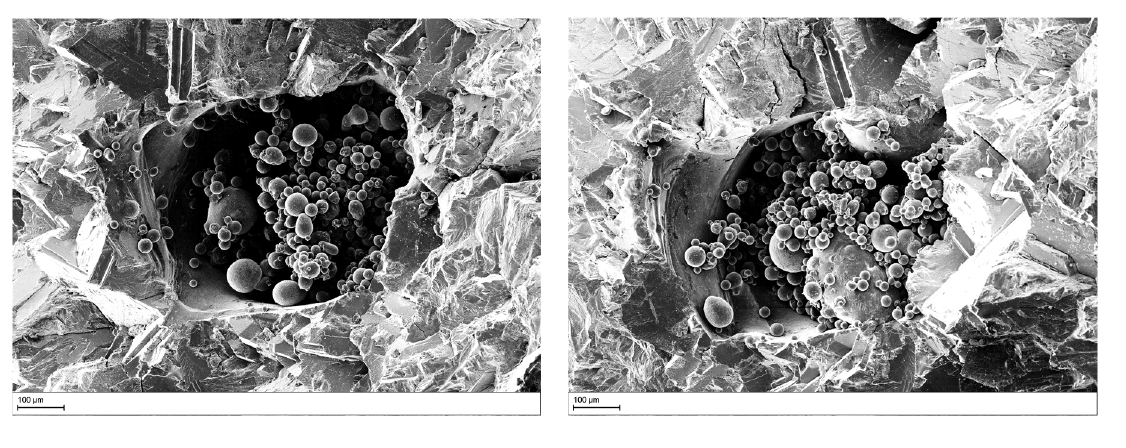
Figure 7. Typical failure location of Inconel 718 samples at the middle of the defect height. Top ( left ) and bottom ( right ) half on the same test